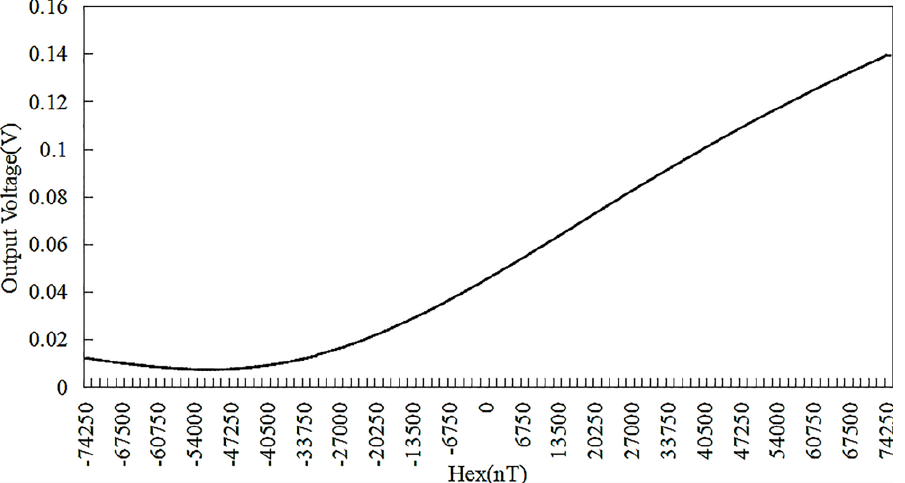
Figure 8. Output characteristic curve of the amorphous wire magnetic sensor sample in the range of the − 74,250 nT~74,250 nT.